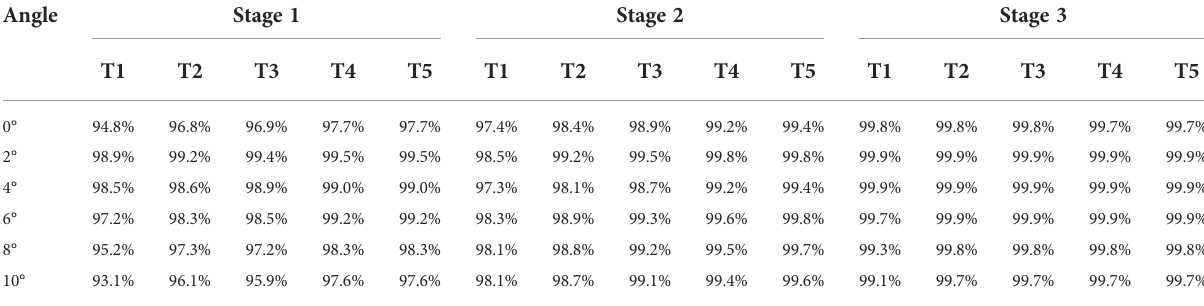
TABLE 5 The overall accuracies for Stages 1 – 3 using the optimal classi fi er – feature assembly at each small incidence angle. Angle Stage